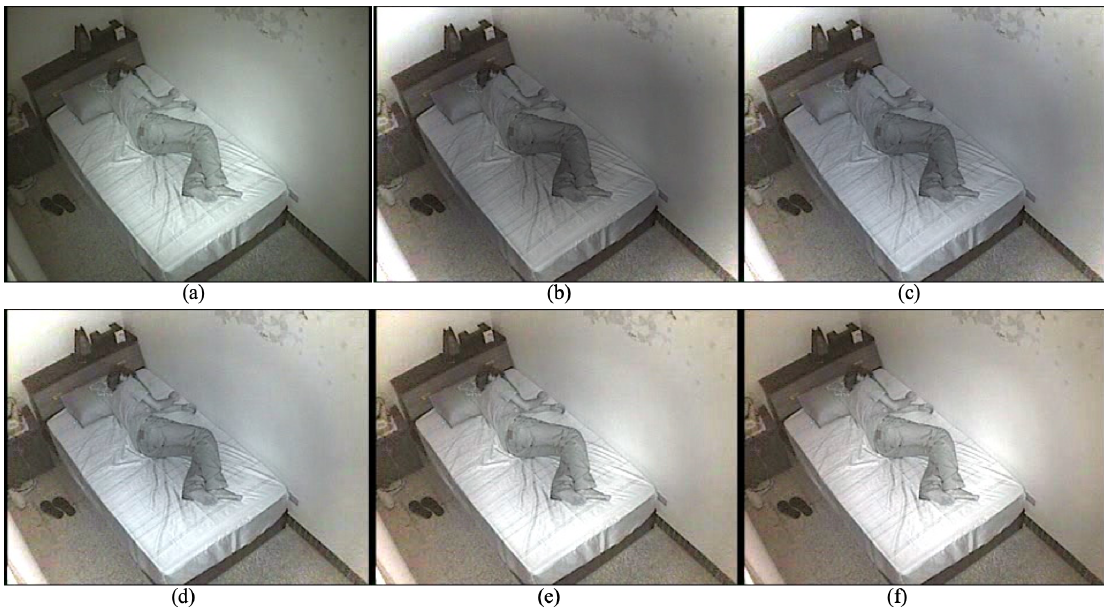
Figure 2. Enhanced NIR images with different Gaussian kernel sizes from 50 to 250. ( a ) Original image. ( b ) c = 50. ( c ) c = 100. ( d ) c = 150. ( e ) c = 200. ( f ) c =